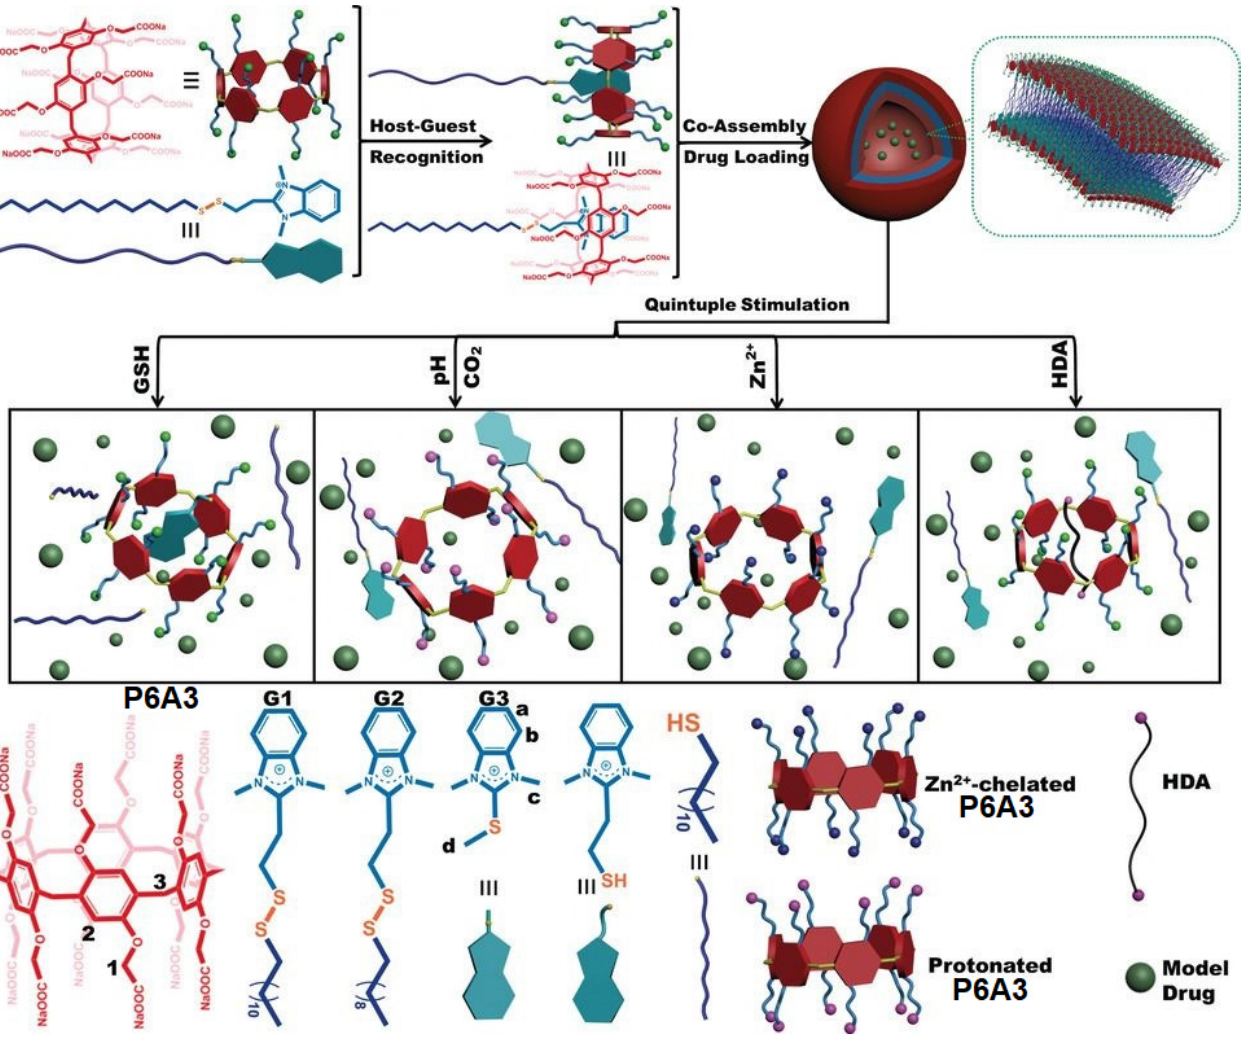
Figure 20. Chemical structures of P6A3 and G1–G3 and illustration of their inclusion complex and DOX-loaded vesicles for controlled drug release. Reproduced from reference [102]. Copyright © Wiley 2017.